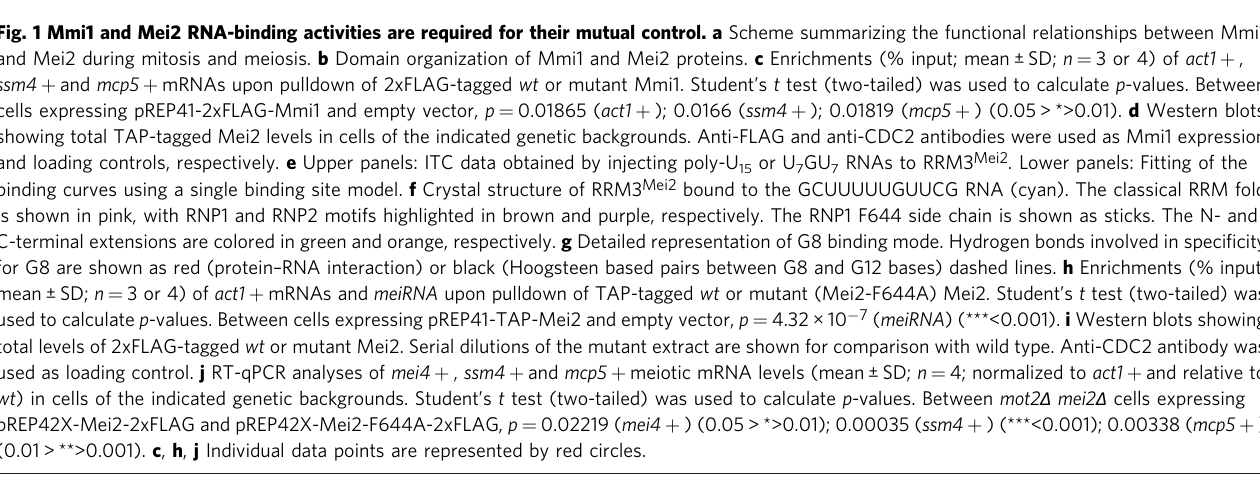
Fig. 1 Mmi1 and Mei2 RNA-binding activities are required for their mutual control. a Scheme summarizing the functional relationships between Mmi1 and Mei2 during mitosis and meiosis. b Domain organization of Mmi1 and Mei2 proteins. c Enrichments (% input; mean ± SD; n = 3 or 4) of act1 + , ssm4 + and mcp5 + mRNAs upon pulldown of 2xFLAG-tagged wt or mutant Mmi1. Student ’ s t test (two-tailed) was used to calculate p -values. Between cells expressing pREP41-2xFLAG-Mmi1 and empty vector, p = 0.01865 ( act1 + ); 0.0166 ( ssm4 + ); 0.01819 ( mcp5 + ) (0.05 > *>0.01). d Western blots showing total TAP-tagged Mei2 levels in cells of the indicated genetic backgrounds. Anti-FLAG and anti-CDC2 antibodies were used as Mmi1 expression and loading controls, respectively. e Upper panels: ITC data obtained by injecting poly-U 15 or U 7 GU 7 RNAs to RRM3 Mei2 . Lower panels: Fitting of the binding curves using a single binding site model. f Crystal structure of RRM3 Mei2 bound to the GCUUUUUGUUCG RNA (cyan). The classical RRM fold is shown in pink, with RNP1 and RNP2 motifs highlighted in brown and purple, respectively. The RNP1 F644 side chain is shown as sticks. The N- and C-terminal extensions are colored in green and orange, respectively. g Detailed representation of G8 binding mode. Hydrogen bonds involved in speci fi city for G8 are shown as red (protein – RNA interaction) or black (Hoogsteen based pairs between G8 and G12 bases) dashed lines. h Enrichments (% input; mean ± SD; n = 3 or 4) of act1 + mRNAs and meiRNA upon pulldown of TAP-tagged wt or mutant (Mei2-F644A) Mei2. Student ’ s t test (two-tailed) was used to calculate p -values. Between cells expressing pREP41-TAP-Mei2 and empty vector, p = 4.32 × 10 − 7 ( meiRNA ) (***<0.001). i Western blots showing total levels of 2xFLAG-tagged wt or mutant Mei2. Serial dilutions of the mutant extract are shown for comparison with wild type. Anti-CDC2 antibody was used as loading control. j RT-qPCR analyses of mei4 + , ssm4 + and mcp5 + meiotic mRNA levels (mean ± SD; n = 4; normalized to act1 + and relative to wt ) in cells of the indicated genetic backgrounds. Student ’ s t test (two-tailed) was used to calculate p -values. Between mot2 Δ mei2 Δ cells